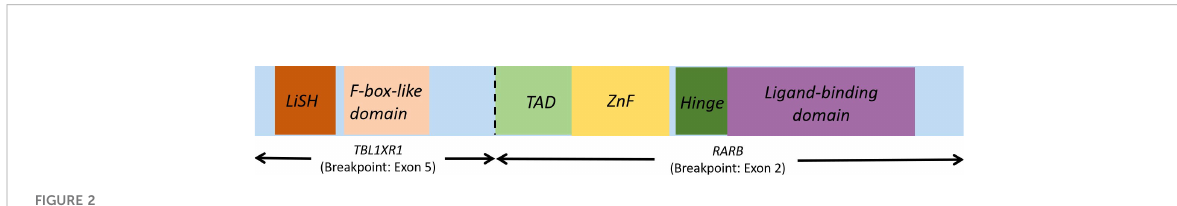
FIGURE 2 TBL1XR1-RARB fusion gene. Lish, Lis homology domain TAD, transcription activation domain, ZnF, Zn fi nger